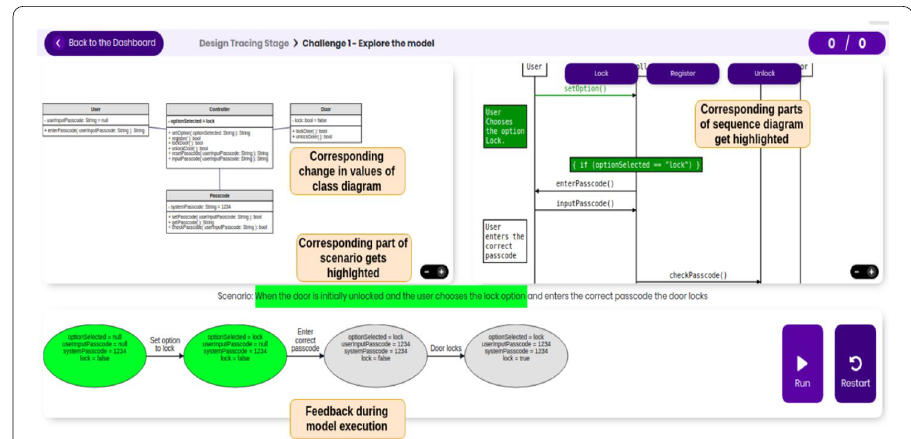
Fig. 12 Affordance of the run feature in the Design Tracing Stage